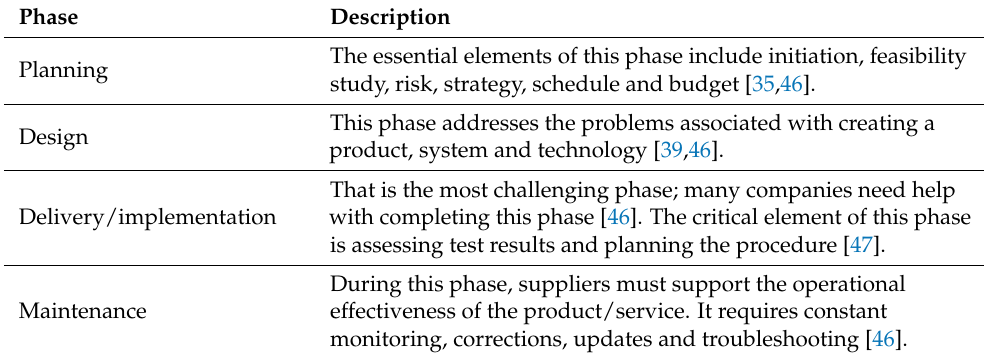
Table 1. The service life cycle’s development.